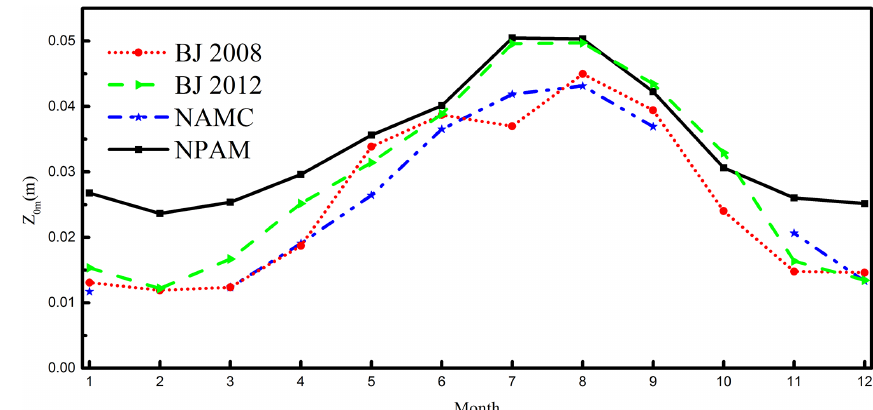
Figure 2. Surface roughness length of different sites on the northern Tibetan